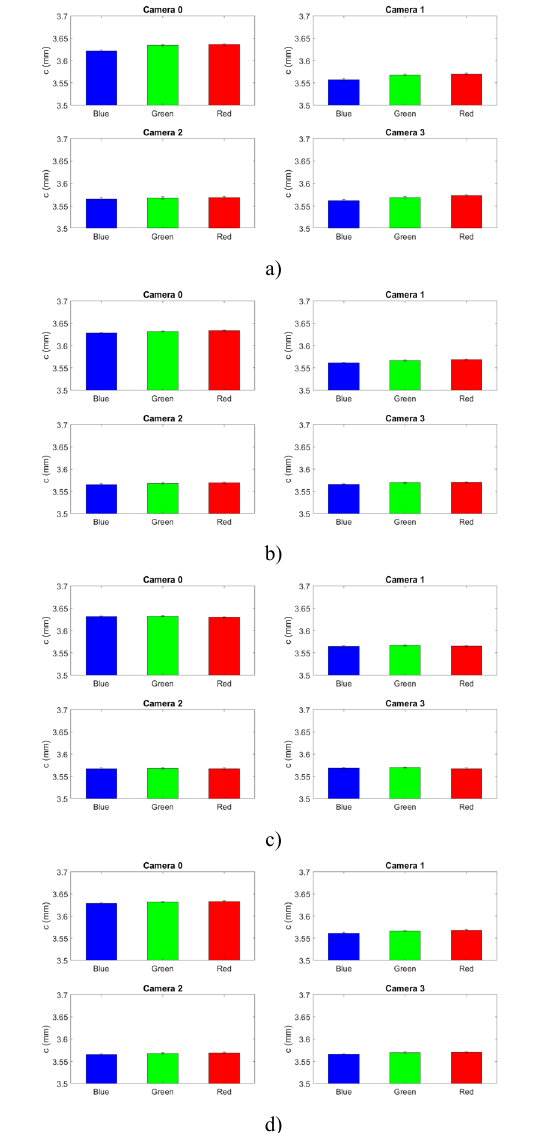
Figure 5. GoPro Hero 5 principal distances and 95% confidence intervals. a) Case 1, b) Case 2, c) Case 3, d) Case